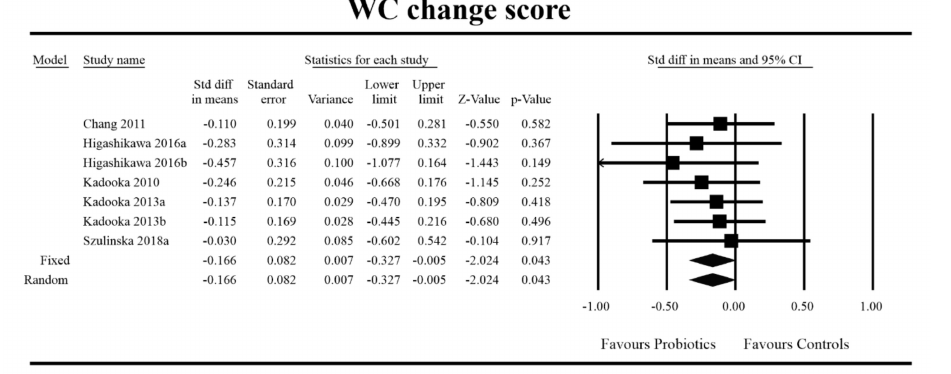
Figure 6. Effect size and standardized mean difference for WC in persons taking probiotics vs. controls (change scores). Q = 1.539, df (Q) = 6, p = 0.959, I-squared = 0.0. WC—waist circumference. [38,49,56,57,81].